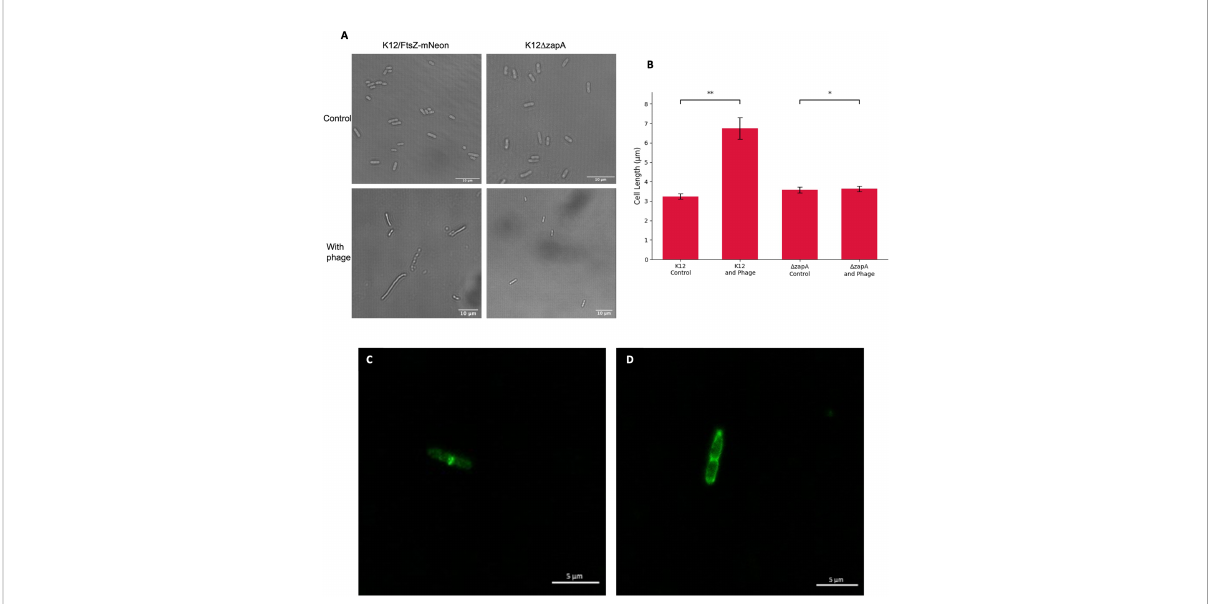
FIGURE 5 Effects of T7 bacteriophage on ZapA and FtsI divisome proteins. (A) Light microscopy images of K12 control and K12 D zapA cells after T7 phage infection. (B) Quanti fi cation of cell length for 75 K12 control and K12 D zapA bacterial cells infected with T7 phage and compared to a no-phage control. Averages plotted with error bars showing one standard deviation of uncertainty. Tukey ’ s tests were performed and the calculated probability values (p-values) are displayed as p < 0.05 (*), p < 0.01 (**), and not statistically signi fi cant p > 0.05 (ns). (C) Escherichia coli K12 cell stained with an FtsI antibody showing localisation of FtsI to the cell midbody as a single ring. (D) E. coli K12 cell after T7 phage infection stained with an FtsI antibody showing mislocalisation of FtsI to three